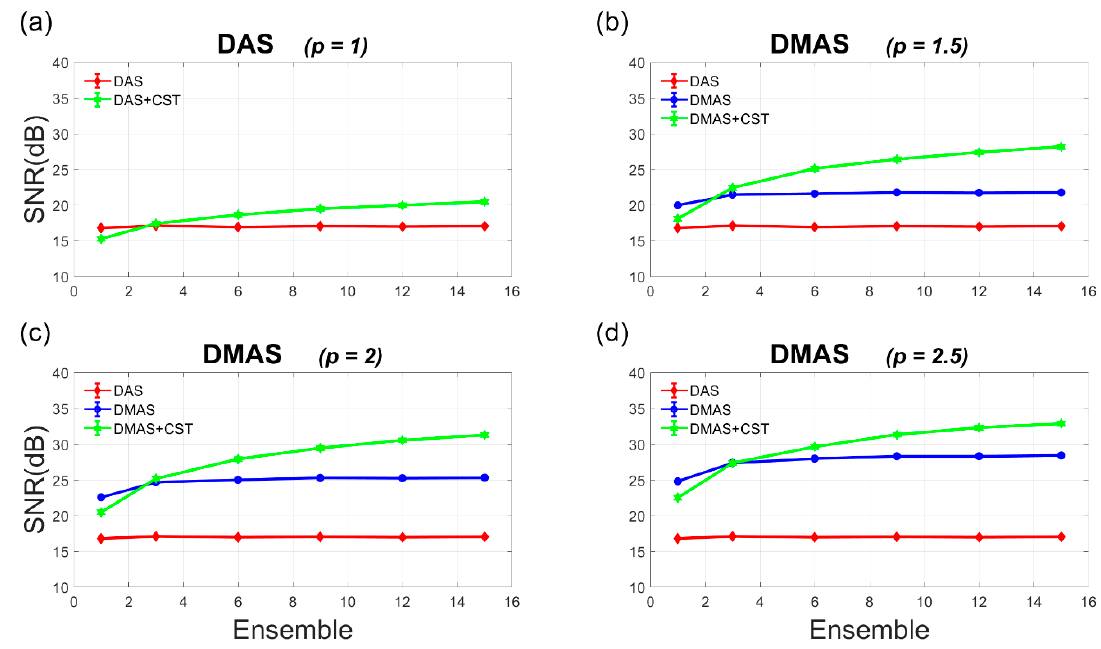
Figure 5. Quantitative analysis of Doppler SNR in the simulations as a function of ensemble number for ( a ) DAS beamforming and ( b – d ) DMAS beamforming with the p value of 1.5, 2.0, and 2.5, respectively.